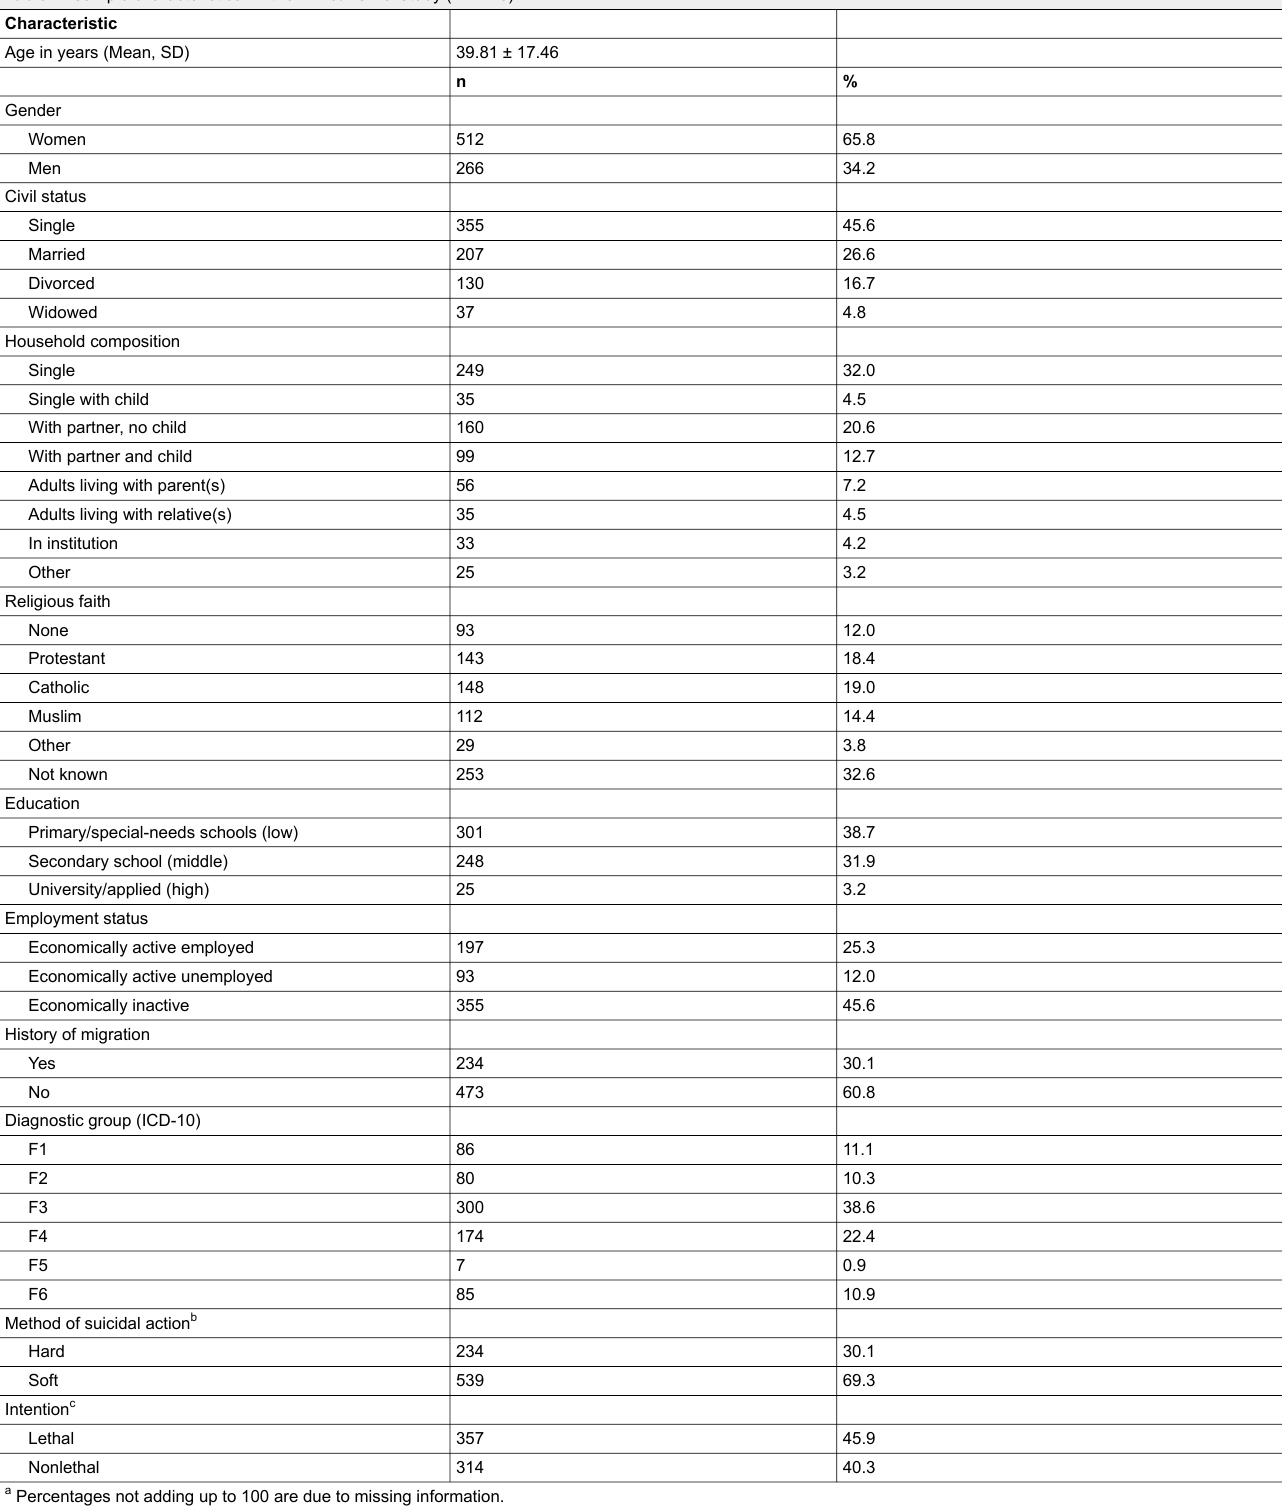
Table 2: Sample characteristics a in the WHO/EURO Study (n =